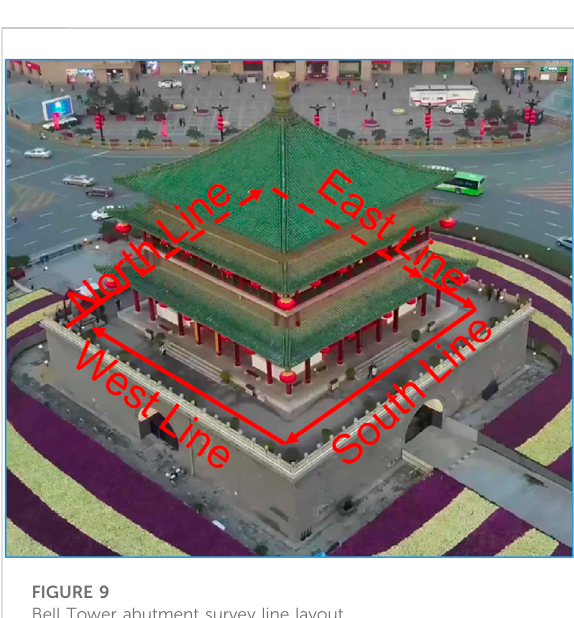
FIGURE 9 Bell Tower abutment survey line